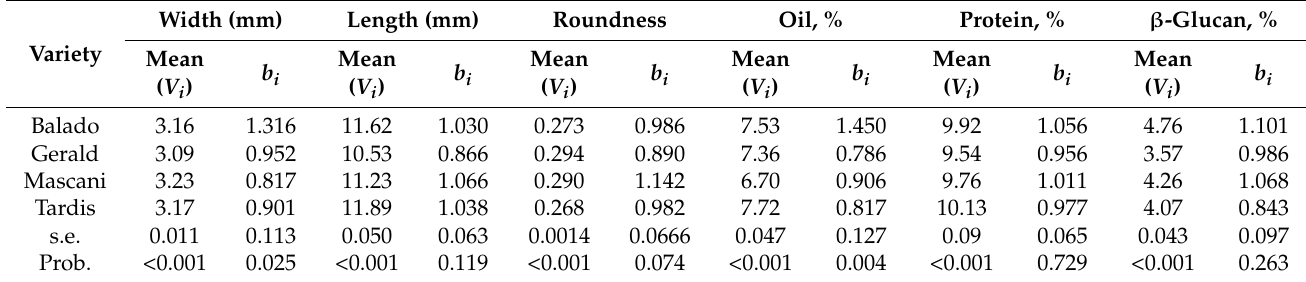
Table 5. Mean grain dimensions (width, length and roundness) and grain composition (oil, protein and β -glucan). of four winter oat varieties grown in 22 environments and sensitivity ( b i ) to environment as determined by modified joint regression